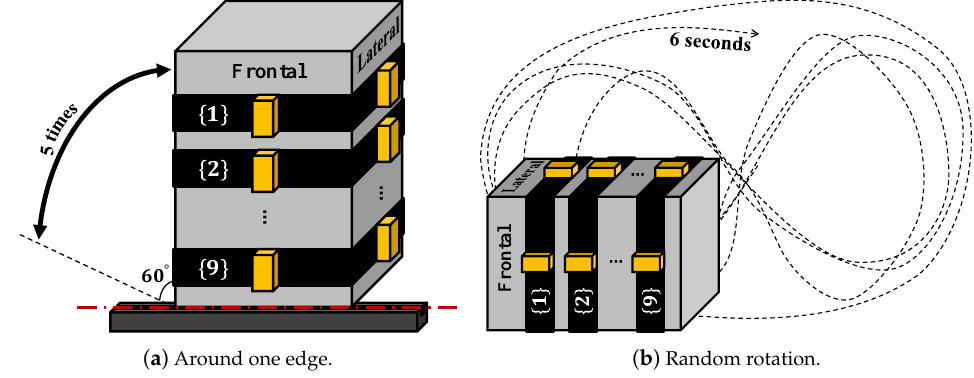
Figure 7. Experiment setup with an aluminum box. Table 4. Acceleration correlation when attaching to an aluminum